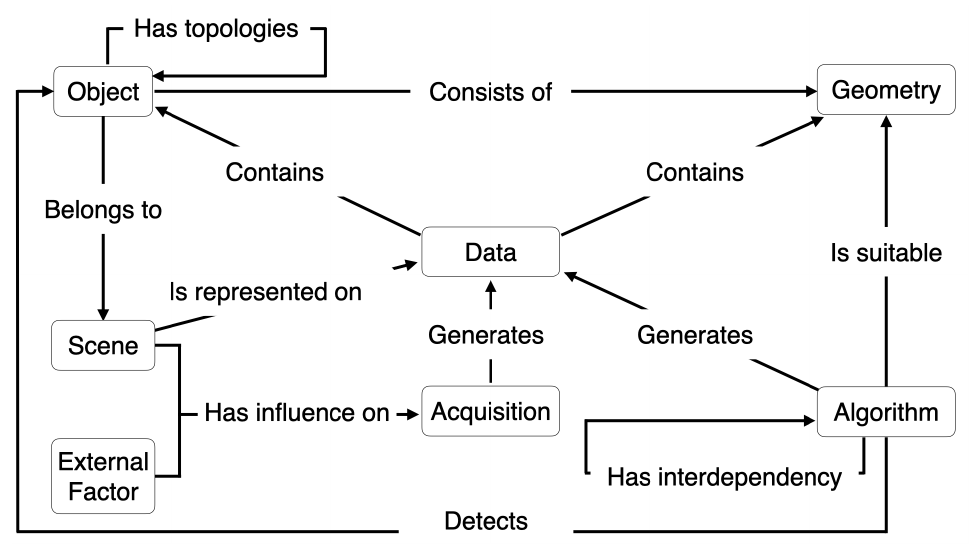
Figure 2. Overview of knowledge